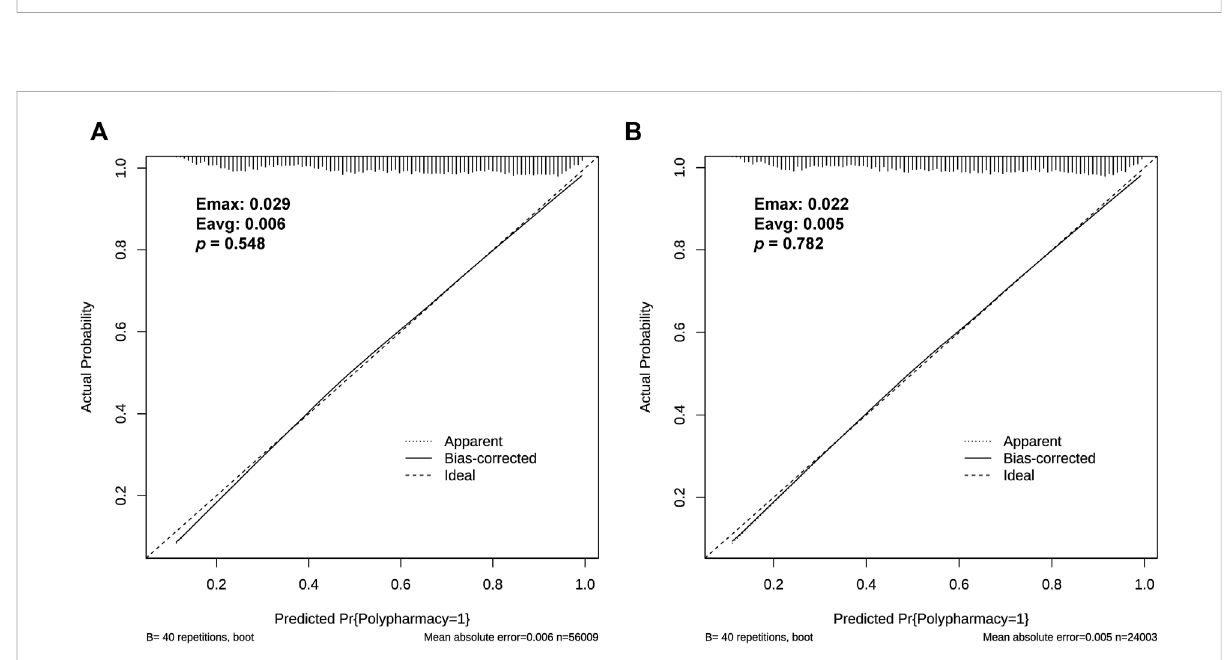
FIGURE 4 Calibration curve of the risk prediction model for polypharmacy in the elderly. The y -axis represents the actual diagnosed cases of polypharmacy,andthe x -axisrepresentsthepredictedriskofpolypharmacy.Theblacksolidlinesabovethe x -axisrepresentthesampledistribution. The dotted line on the diagonal indicates the perfect prediction of the ideal model, and the solid line indicates the performance of both sets respectively [ (A) :training set; (B) validationset]. P > 0.05 meansthat thecalibrationtesthaspassed.The closerthesolidline isto thedotted line, the better the predictive effect